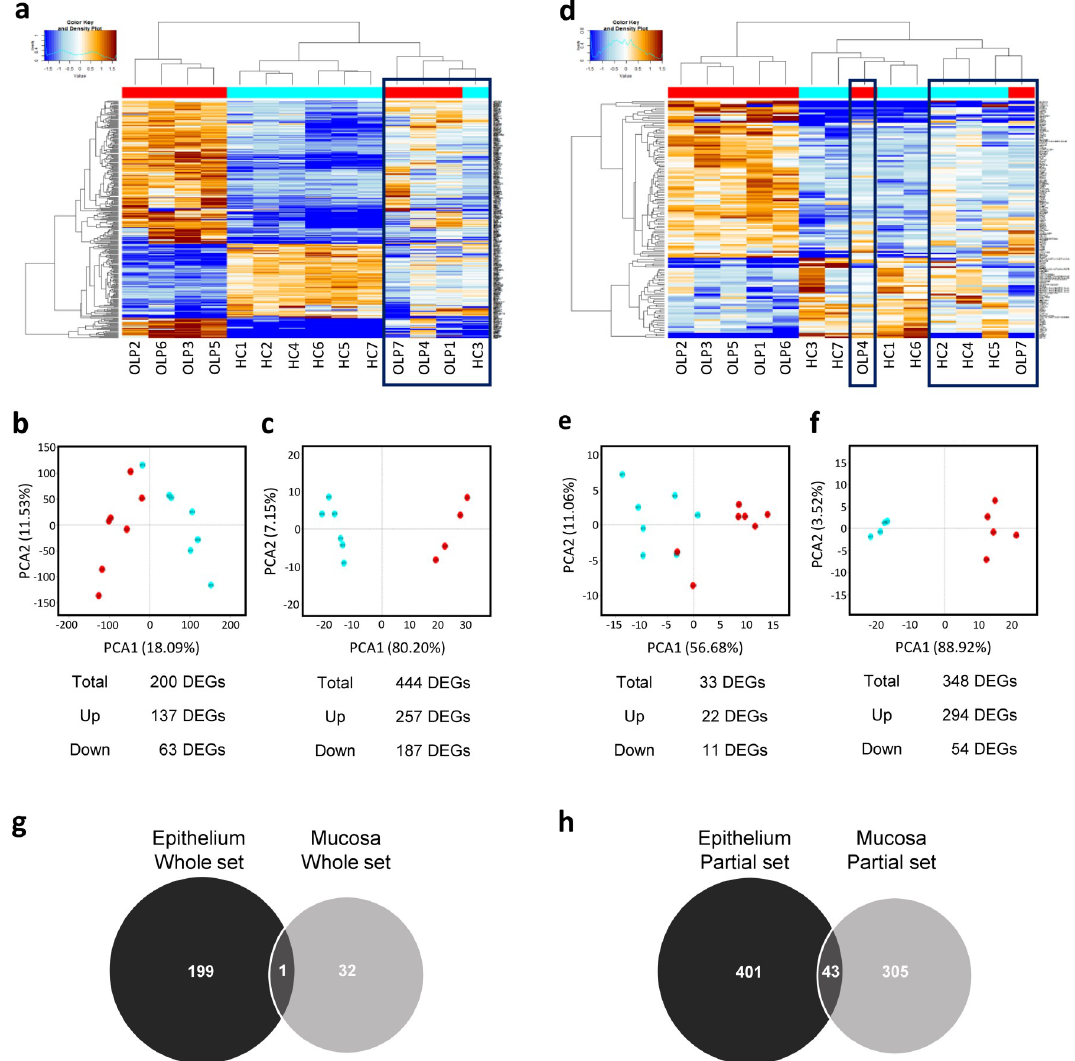
Fig 1. Differentially expressed gene (DEG) analysis using the two datasets GSE52130 and GSE38616. (a-c) GSE52130, the transcriptome of the epithelium, and (d-f) GSE38616, the transcriptome of the mucosa, were downloaded from the GEO database and analyzed. (a, d) Heat maps of DEGs combined with hierarchical clustering. The color change from brown to blue represents the change from upregulation to downregulation. Black squares marks outliers removed in the partial sets. (b,c,e,f) Principal coordinate analysis plots of the whole (b,e) and partial (c,f) datasets. (g,h) Venn diagram illustrating the number of DEGs in the two whole (g) and partial (h) datasets. The black circle represents the GSE52130 dataset, and the gray circle represents the GSE38616 dataset. The intersection of the 2 circles indicates the overlapping DEGs between the two